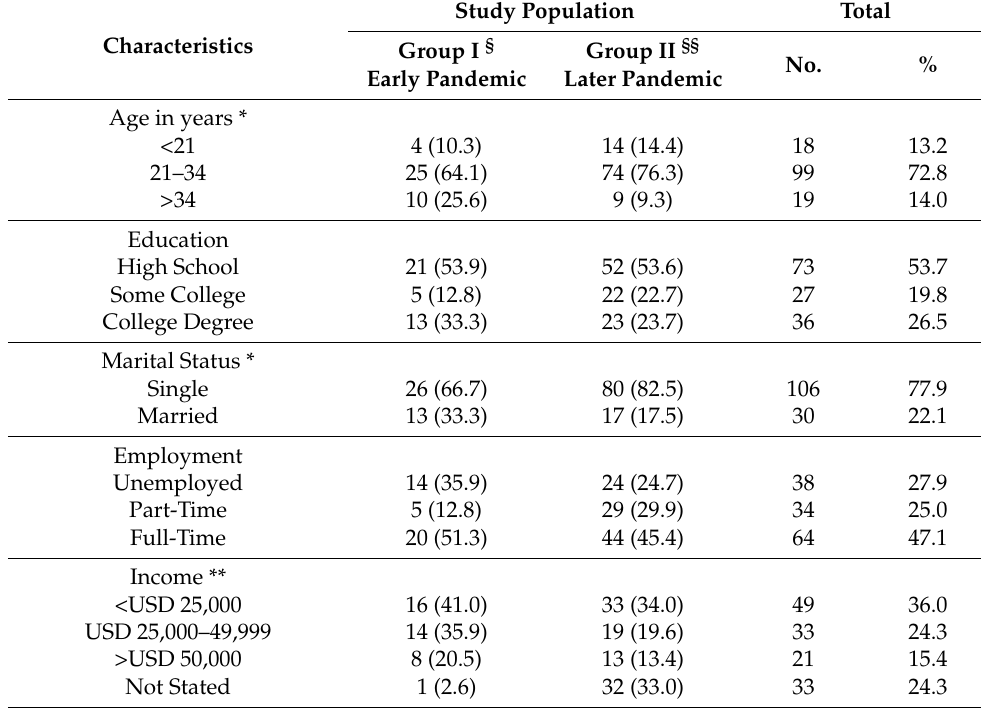
Table 1. Demographic characteristics of participating mothers during the early and later COVID-19 pandemic